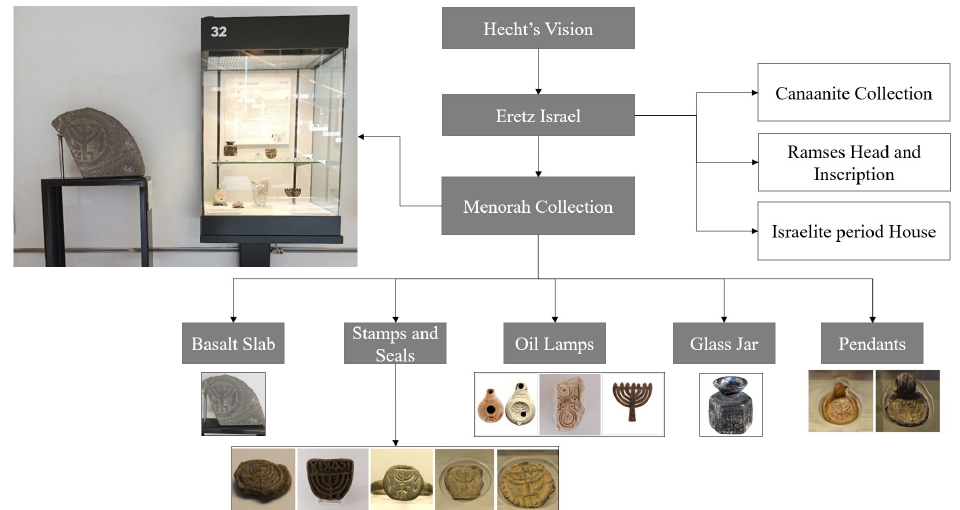
Figure 1. Recommended groups of artefacts in the Hecht Museum for the digital multimedia application with the final selection and its component sub-groups